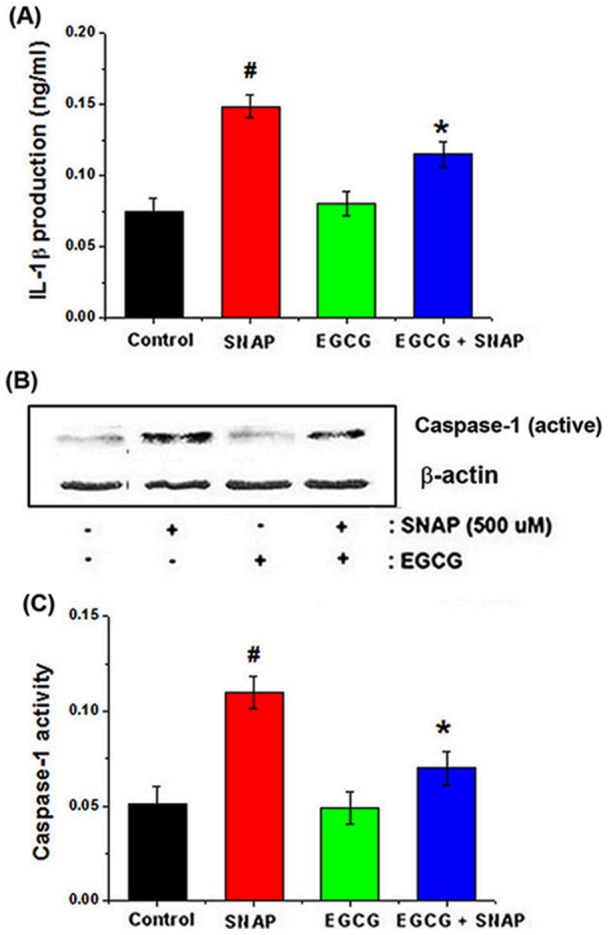
Effects of EGCG on NO-induced caspase-1 activation in vitro and ex vivo.
Cells were pretreated with 50 μM EGCG, followed by treatment with 500 μM SNAP for 24 h. (A) IL-1β concentrations were measured in cell supernatants using the ELISA method. (B) Protein extracts were assayed for cleaved caspase-1 by western blot analysis. (C) Rat organ of Corti explants were pretreated with 50 μM EGCG for 2 h, followed by treatment with 500 μM SNAP. After the explants were homogenized, caspase-1 levels were confirmed using a caspase-1 assay kit. All data represent the mean ± SEM of 3 independent experiments (#P<0.05 vs. control, *P<0.05 vs. SNAP alone).